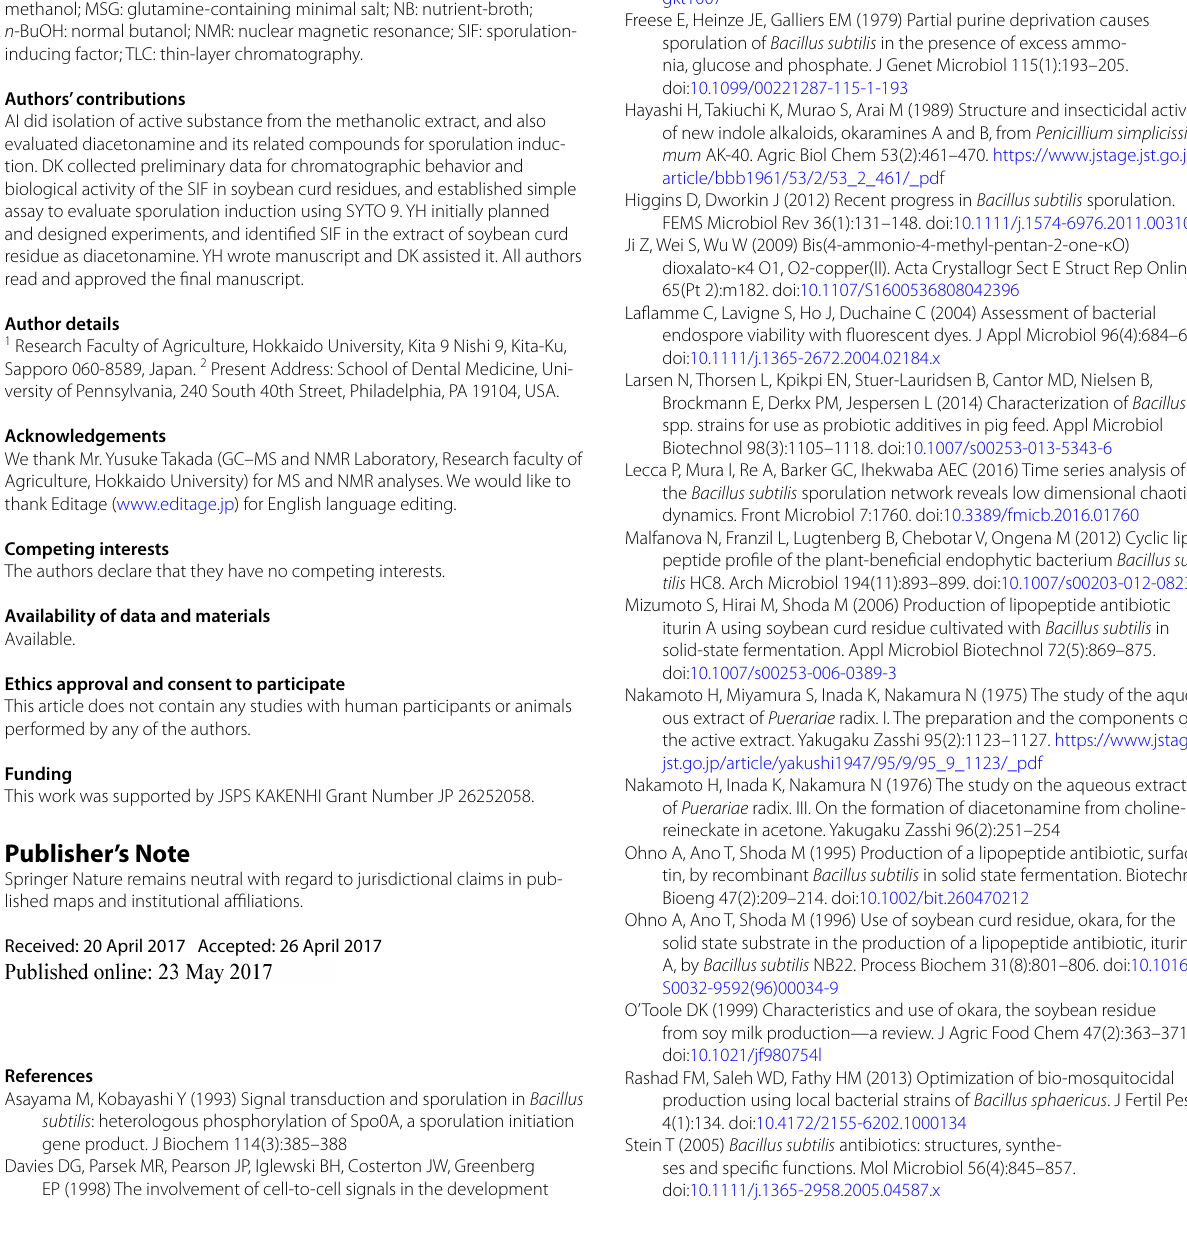
Additional file 1: Figure S1. Activity of methanolic extract from soybean curd residues in antibiotic